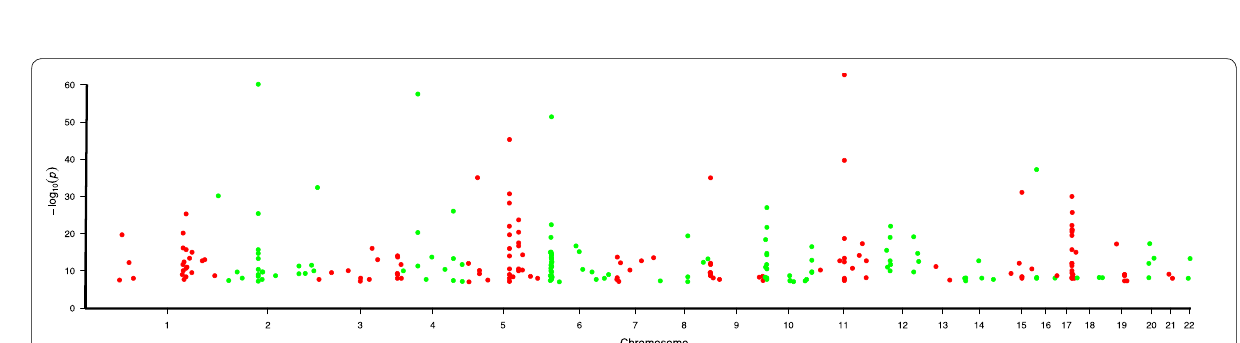
Fig. 2 Manhattan plot (https ://biore nder.com/) of the SNPs that were significantly associated (p < 5